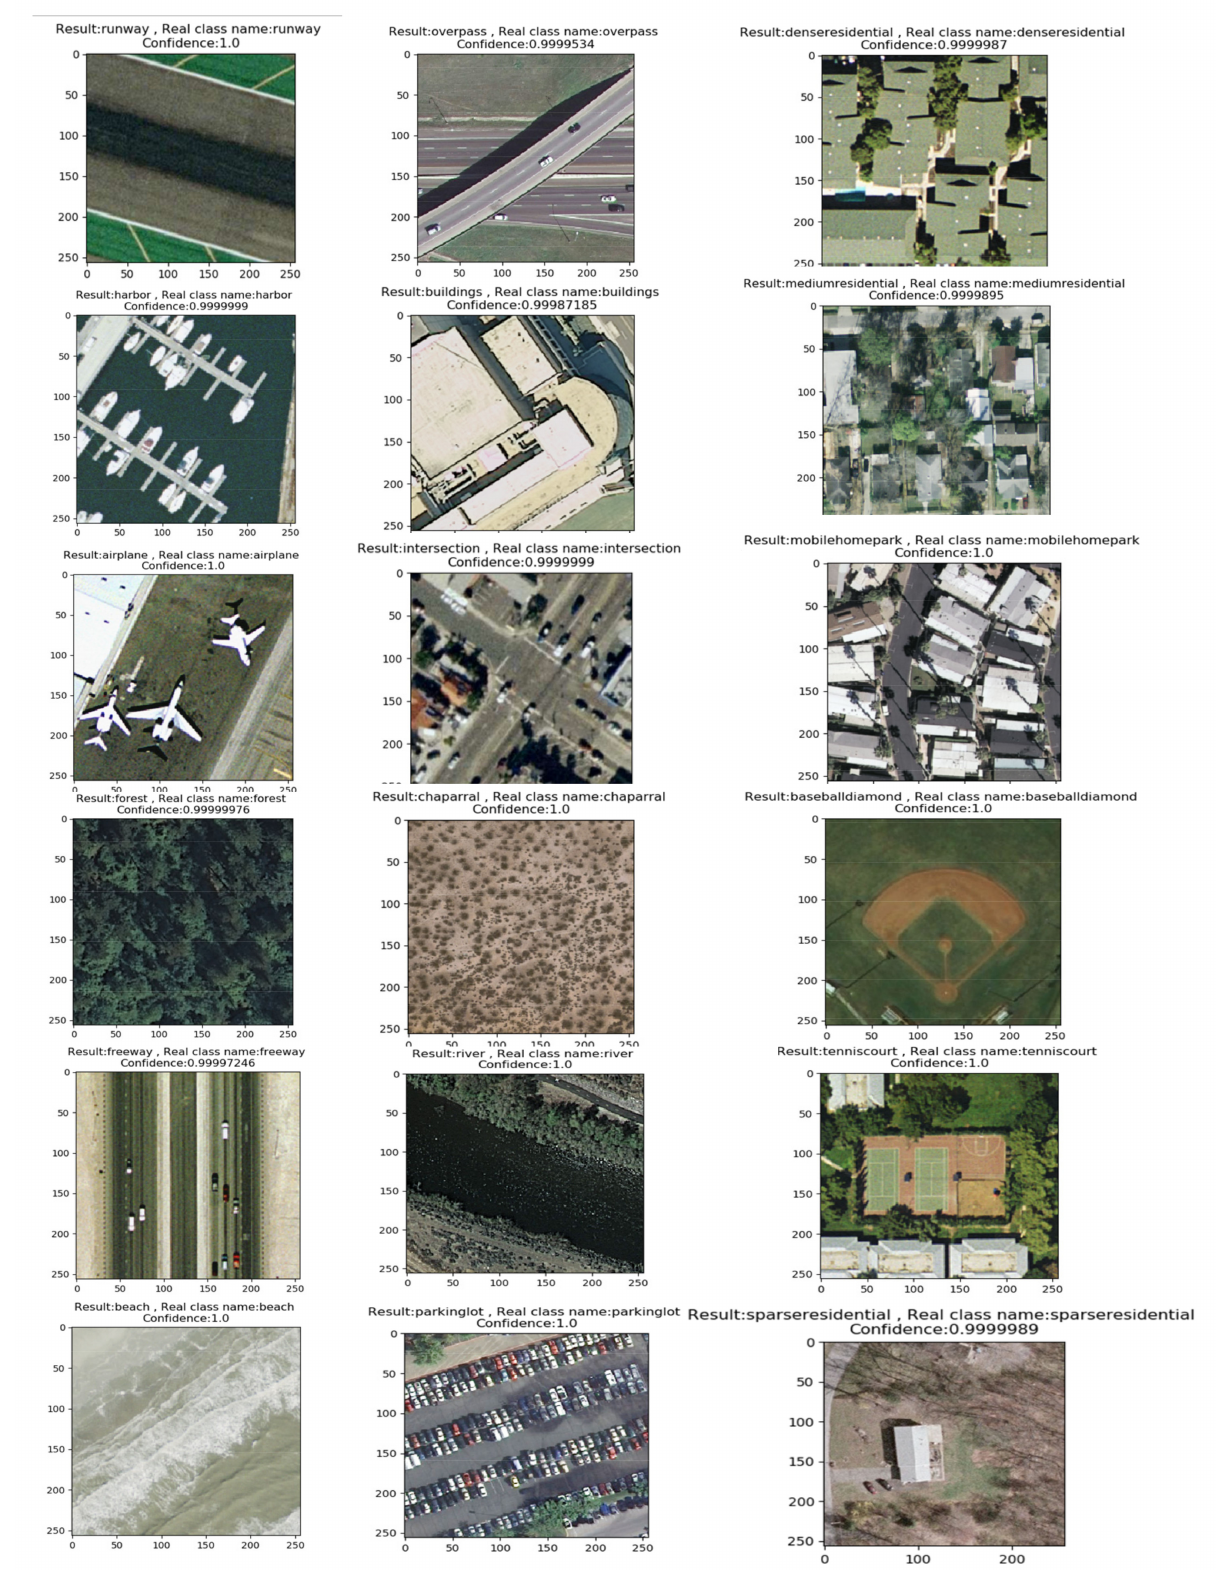
Figure 14. Random classification prediction